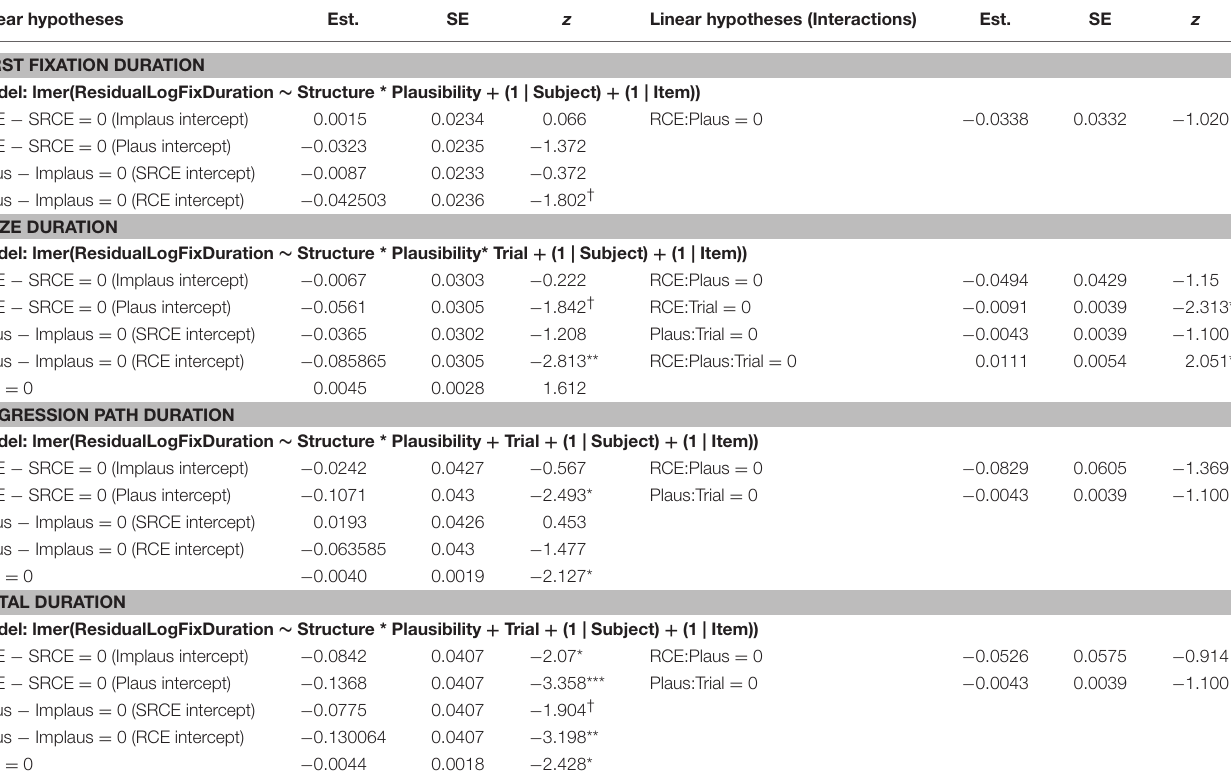
TABLE 7 | Experiment 2 R01 (Embedded verb): Simultaneous tests for general linear hypotheses for linear effects models fitted to log-transformed and residualized fixation durations. Linear hypotheses Est. SE z Linear hypotheses (Interactions) Est. SE